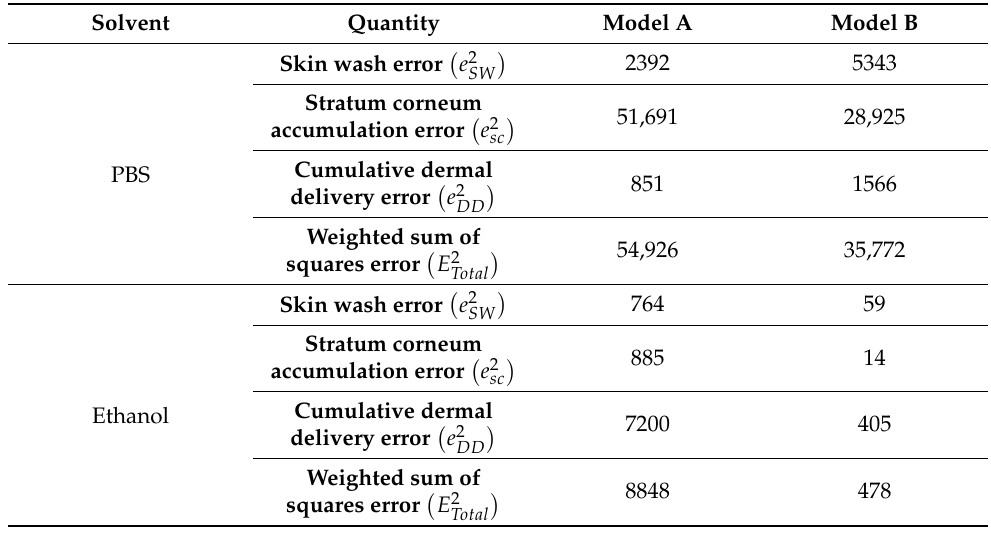
Table 5. Summary of squared model errors defined in Table A4 at t = 24 h summed over IVPTs selected for model assessment for PBS and ethanol solvents (see Table A4).